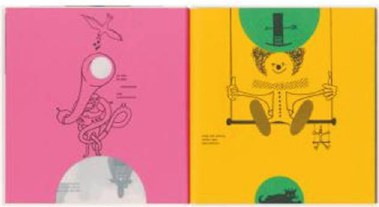
Figure 1. Munari B., Nella nebbia di Milano , ed. italiana e inglese; Corraini, Italia 2008, [1].